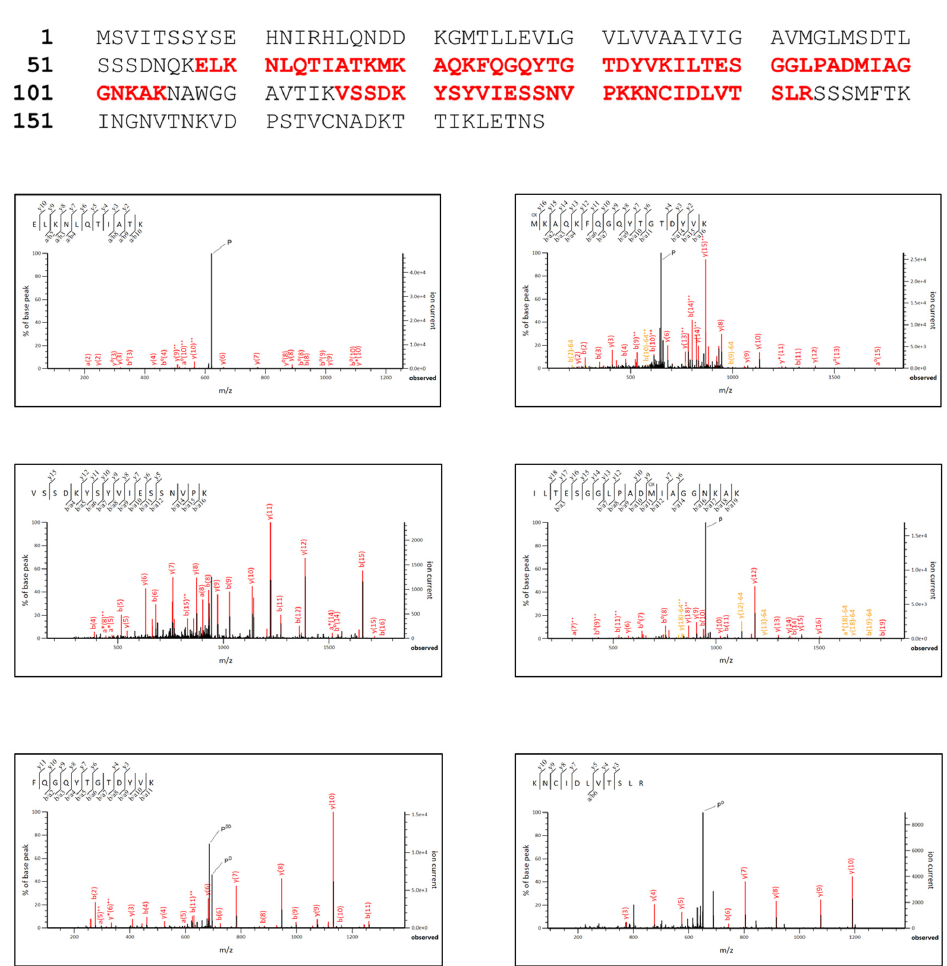
Figure 4. Mass spectrometry identification by shotgun proteomics analysis. Identified peptides in rPilS are shown in the top panel and each corresponding peptide spectra is shown below. Fragment -b and -y ions of each peptide identified in MS/MS are shown in the top left corner of the spectra. P = parent ion. P 0 = parent ion-H 2 O, P 00 = parent ion-2H 2 O, * = -NH 3 , 0 = -H 2 O, ++ = +2 charge, OX = oxidation (of Methionine).